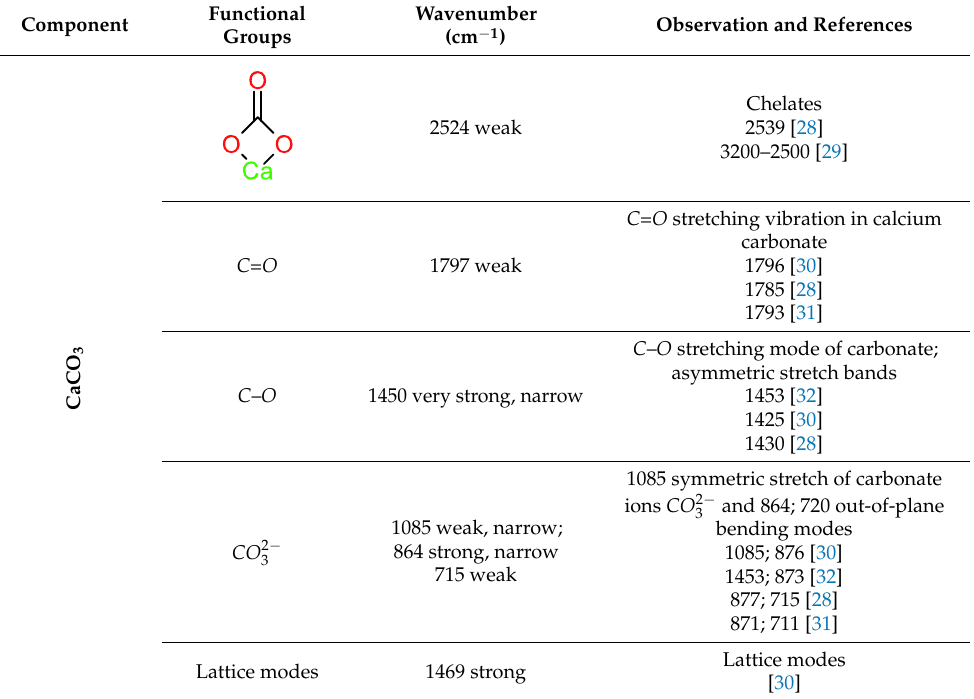
Figure 4. Calcium carbonate, CaCO 3 , structural formula ( a ); chitin, β -(1,4)- N -acetylglucosamine, structural formula ( b ) and chitosan, β -(1,4)- D -glucosamine, structural formula ( c ). The detailed analysis of the FTIR spectra is presented below. Table 1. Oyster shell biocomposite material main components — the FTIR spectrum bands and interpretation.